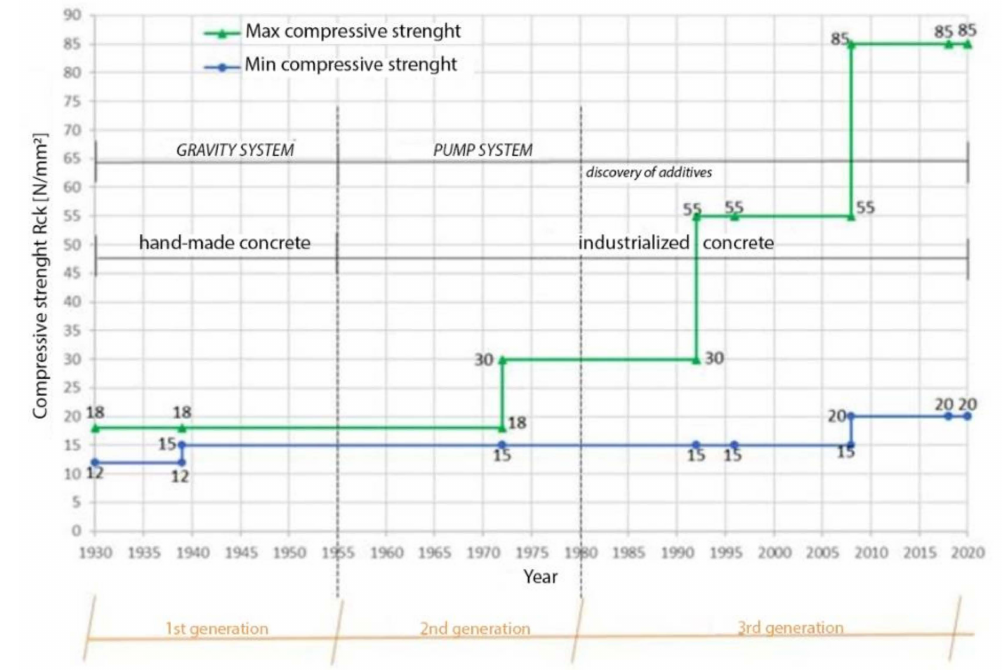
Figure 3. Evolution of the concrete strength from 1930 to today